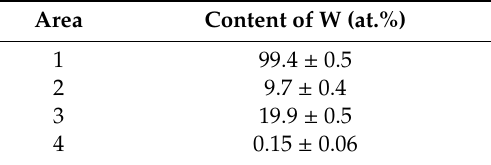
Figure 2. ( a ) Scanning electron microscopy back-scattered electron (SEM-BSE) image of the W – Al- PAM-1 alloy; ( b ) optical microscopy (OM) image of the W – Al-PAM-2-alloy. alloy; ( b ) optical microscopy (OM) image of the W–Al-PAM-2-alloy. Table 2. Determined chemical composition in individual areas by EDS. Table 2. Determined chemical composition in individual areas by